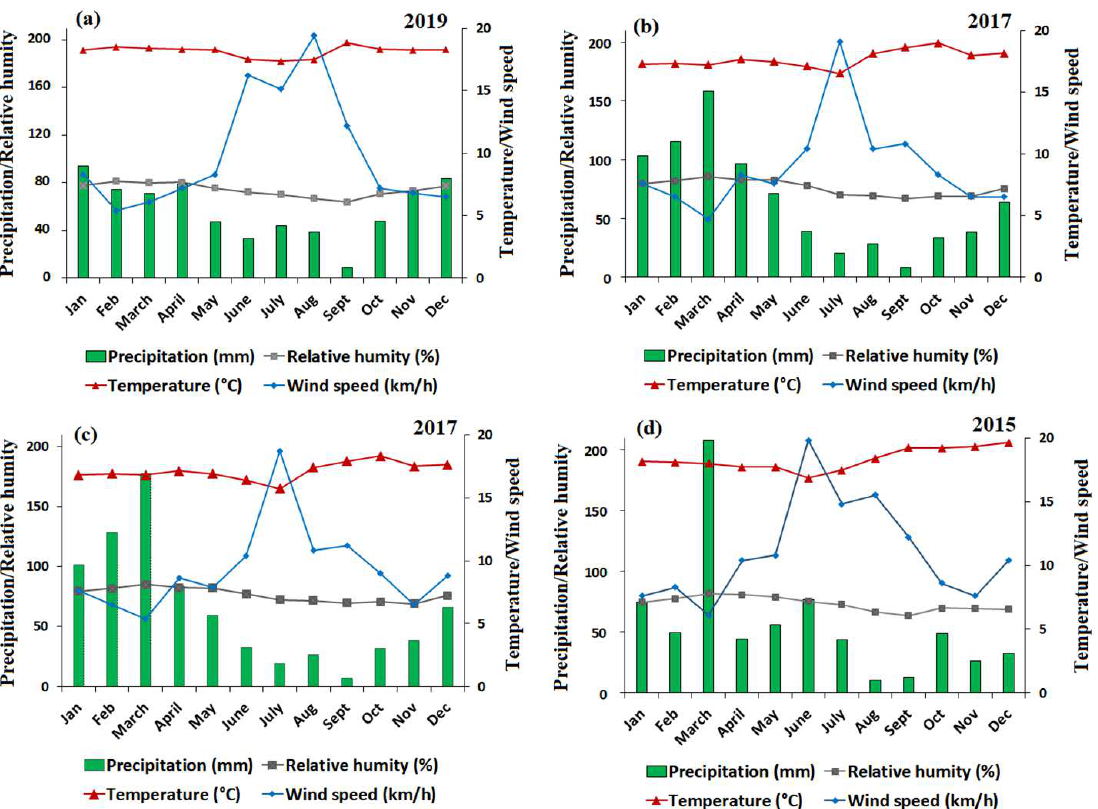
Figure 3. Climographs according to each sampling site. ( a ) Climograph of zones 1 and 2 of the year 2019. ( b ) Climograph of zone 1 of the year 2017. ( c ) Climograph of zone 2 of the year 2017. ( d ) Climograph of zones 1 and 2 of the year 2015. The climatic data were determined using meteorological data from NASA.